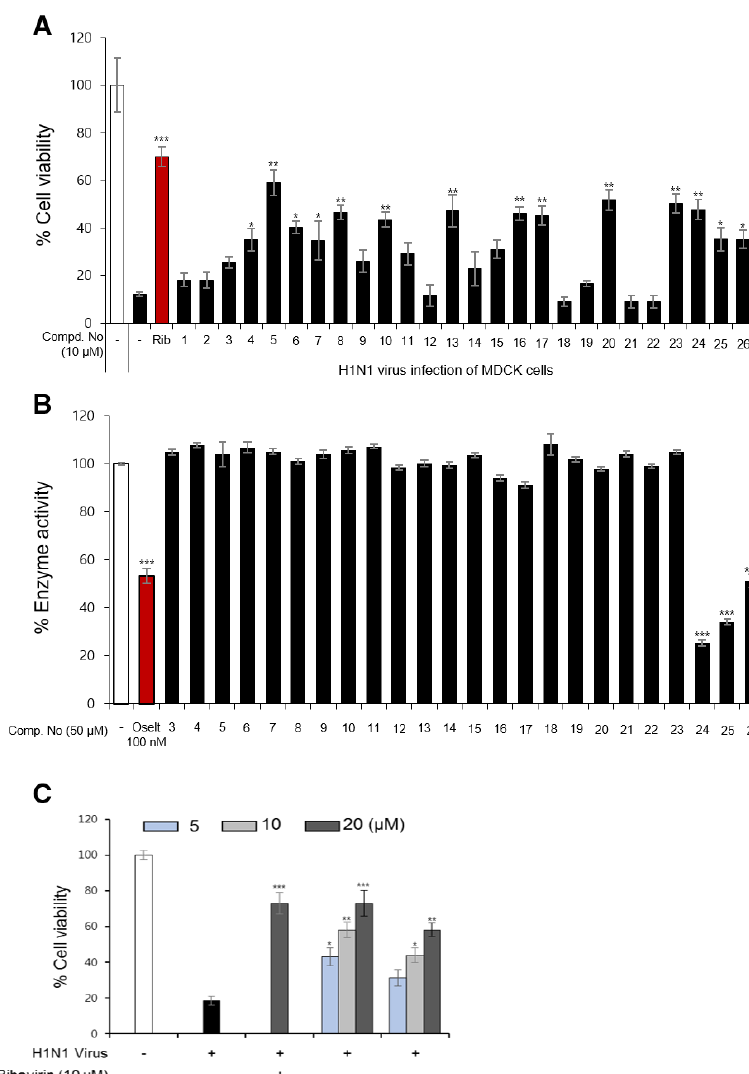
Figure 3. Antiviral activities of isolated compounds against the H1N1 A/PR/8/34 virus in the cytopathic effect (CPE) inhibition and neuraminidase (NA) inhibition assays. ( A ) The percent cell survival was evaluated by the effects of all isolated compounds ( 1 − 26 ) and ribavirin (Rib), a positive control, at 10 µ M with the use of the CPE inhibition assay. ( B ) The inhibitory effects of compounds 3 − 26 at 50 µ M and oseltamivir (Oselt; 100 nM), a positive control, on NA from H1N1. ( C ) The influence of compounds 5 and 24 (5, 10, and 20 μ M) on cell viability was investigated using the CPE inhibition assay. Values are expressed as the mean ± SD of three independent experiments, * p < 0.05, ** p < 0.01, and *** p < 0.001 compared to the virus control group (one-way analysis of variance followed by a two-tailed Student's t-test).